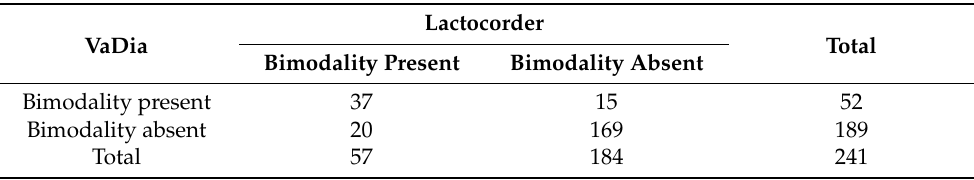
Table 3. Amount of bimodality assessed with the VaDia vacuum recorder (Biocontrol, Rakkestad, Norway) and Lactocorder (WMB AG, Balgach, Switzerland) from 241 individual cow milk- ing